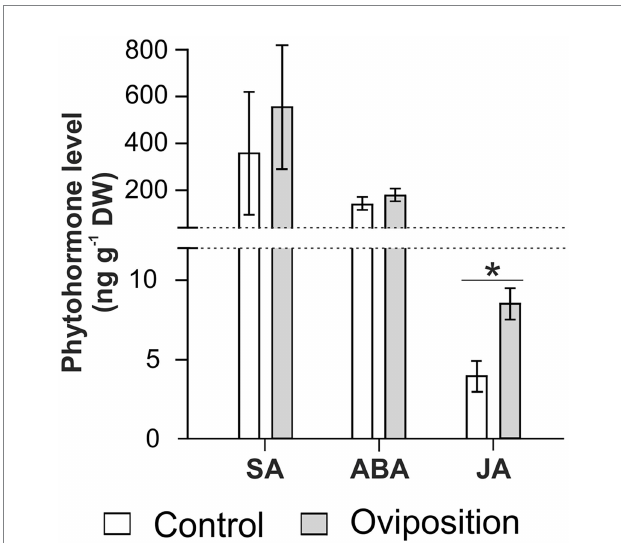
FIGURE 5 Phytohormone levels (means ± estimated SEM) in control and oviposited Salix babylonica leaves 4 days after Nematus oligospilus egg- laying. Concentrations of salicylic acid (SA), abscisic acid (ABA) and jasmonic acid (JA) in egg-free (control: white bars) and oviposited leaves (oviposition: gray bars). Statistical analysis for mean values was performed by LMMs between treatments. Asterisk (*) indicates significant difference between oviposited and control leaves for JA, (p < 0.05). Non- significant differences were found for the rest of the compounds. Biological replicates (plants) per treatment: N =